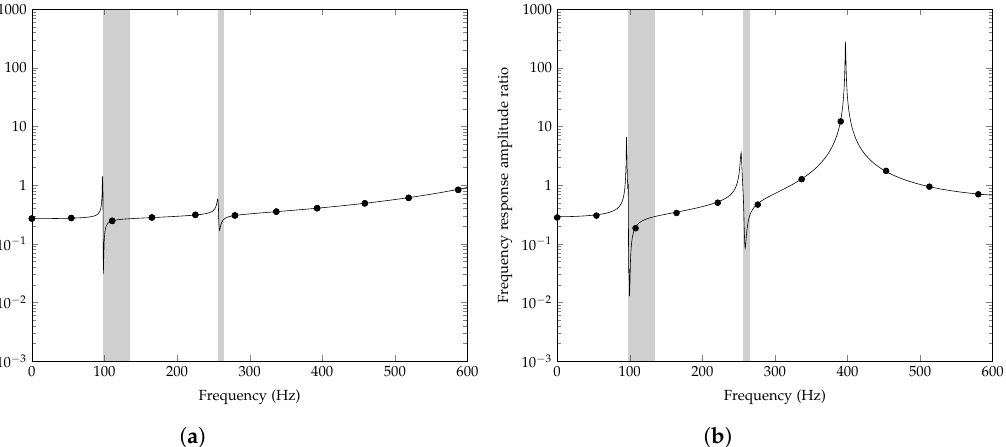
Figure 9. LRMP in Figure 3, amplitude ratio of the deflection frequency response at ( 0.175,0.10 ) to the deflection frequency response at the application point ( 0.025,0.10 ) of a unit harmonic force, calculated by the dynamic-stiffness approach (black continuous line) and FE model in ABAQUS (black dots), considering: ( a ) all edges simply supported; ( b ) two edges simply supported and two edges